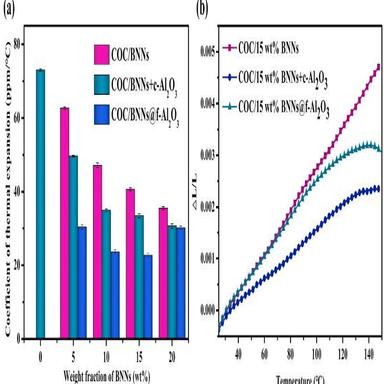
(a) The coefficient of thermal expansion of various composites in the temperature range of 25–150 ◦C; (b) The dynamic mechanical curves of COC-based composites corresponding to temperature.